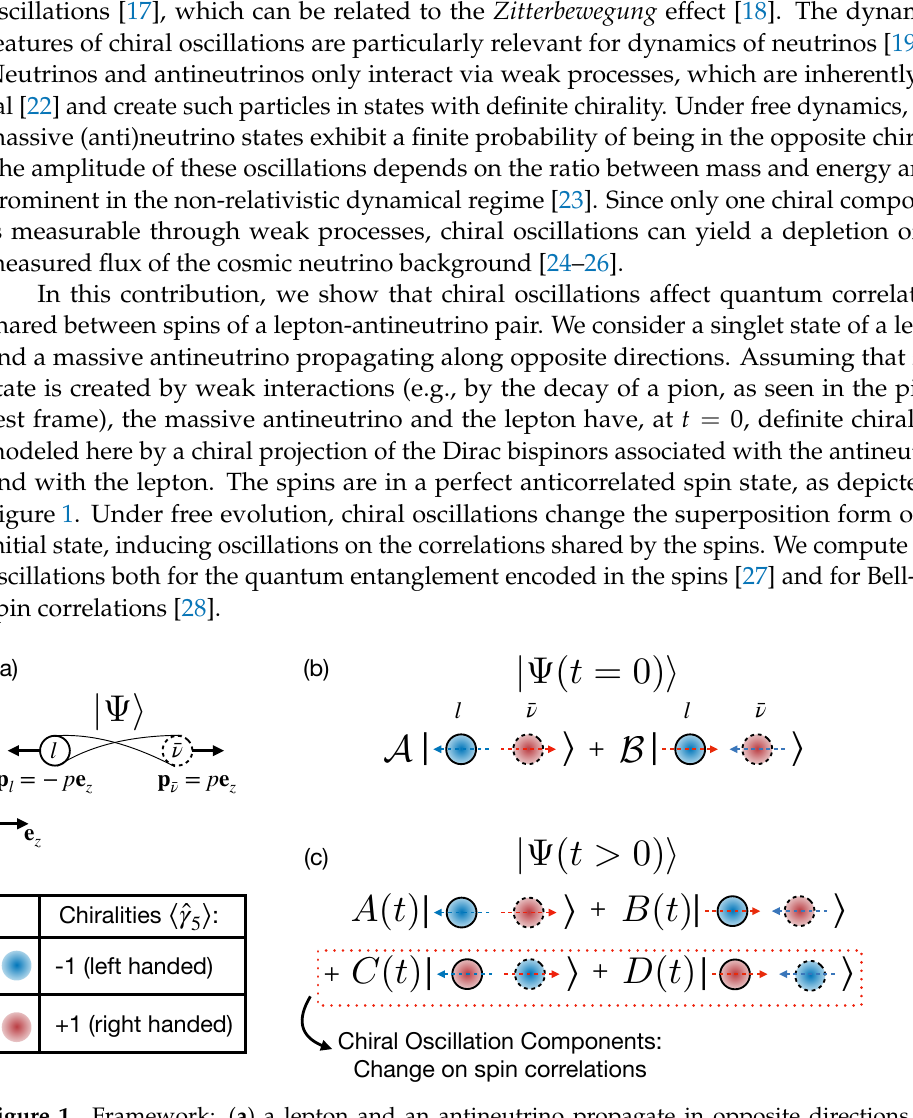
Figure 1. Framework: ( a ) a lepton and an antineutrino propagate in opposite directions with same momentum. Each is described by a Dirac bispinor, carrying spin and chirality degrees of freedom. ( b ) At t = 0, the state is a superposition in which the lepton and the antineutrino have definite chiralities. The coefficients and depend on the masses of the particles and on the A B momentum. ( c ) Under free evolution, the chiralities oscillate, changing the initial superposition and the correlations shared between the